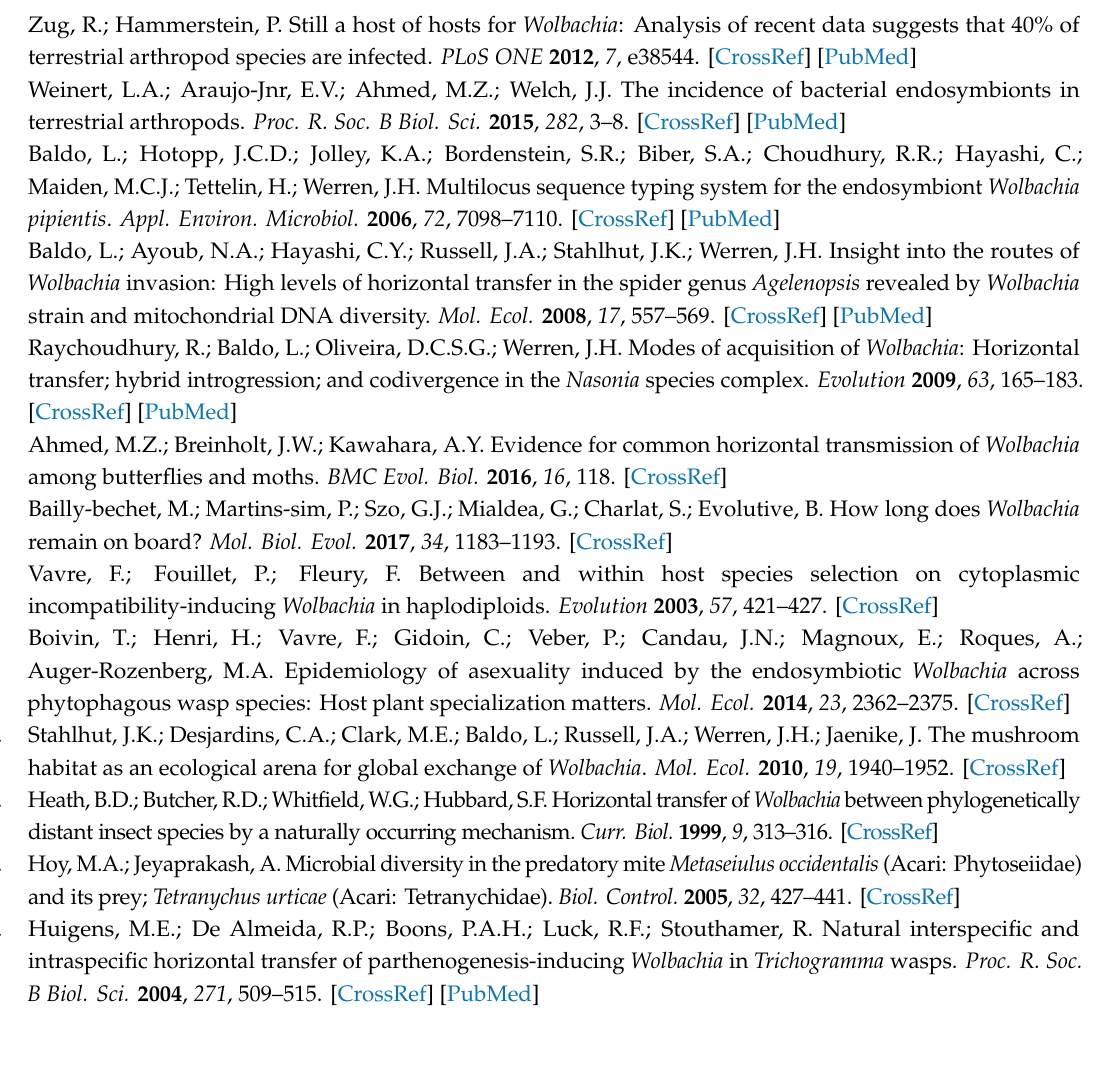
Figure S1: Alignment of Illumina paired-end sequence reads to the reference MLST sequences, Figure S2: Genealogical relationships of Wolbachia strains based on the wsp gene, Table S1: Behavioral di ff erences between non-integrated and integrated ant crickets based on Ooi (2019), Table S2: Recorded host ants of the tested ant cricket species, Table S3: Profile information of the ant cricket samples used in this study, Table S4: Primer sequences for the wsp gene and PCR conditions used in this